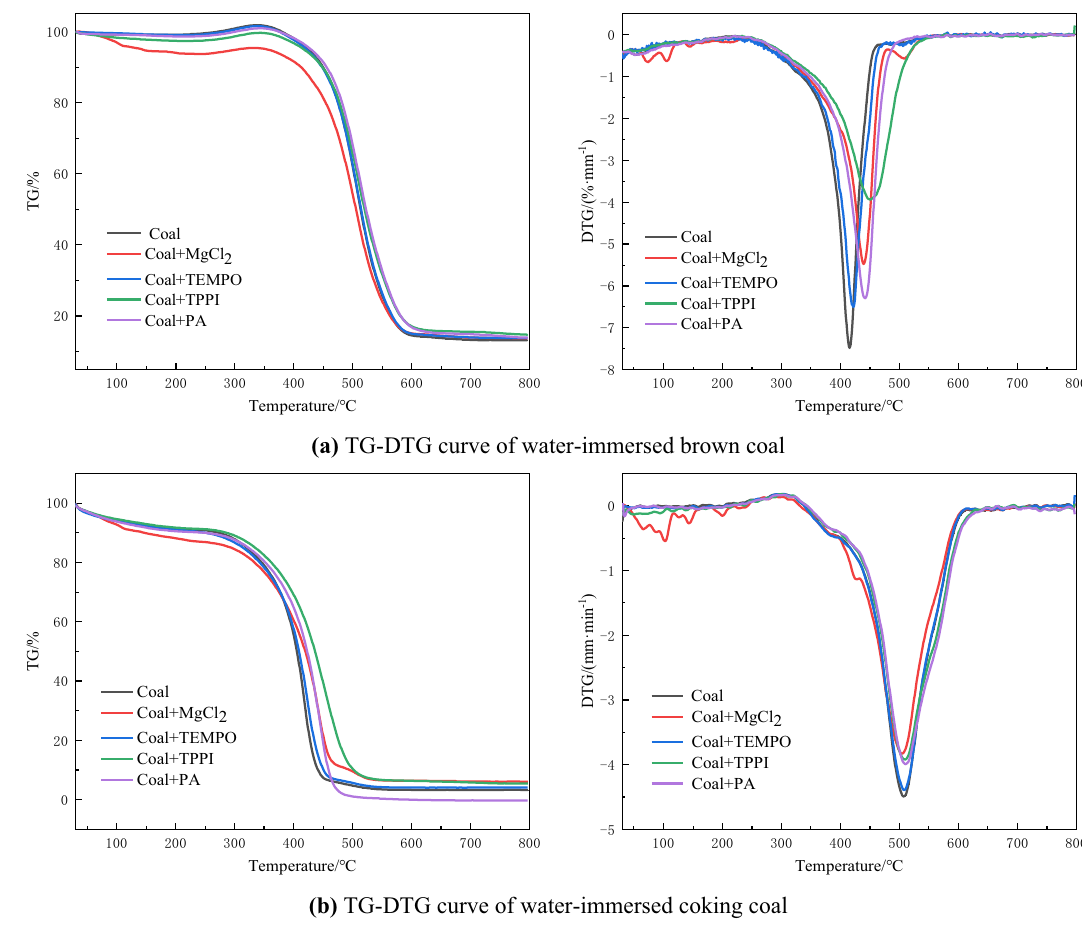
Figure 4. Thermal analysis curves of water-immersed coal samples with different degrees of metamorphism.